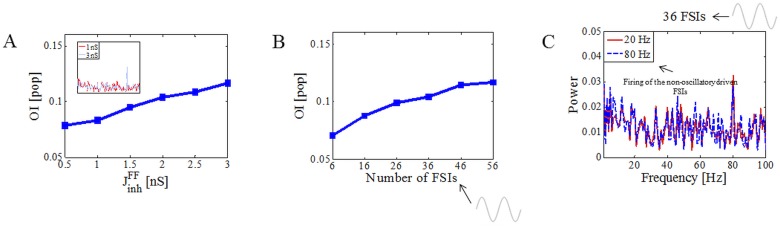
Sensitivity of the oscillations in the MSN population to the parameters of the FF inhibition.(A) Increase in the strength of FF inhibition enhanced the transfer of oscillations from FSIs to MSNs as indicated by a monotonic increase in the OI of MSNs. (B) OI of MSNs also monotonically increased as a fraction of stimulated FSIs increased. (C) Influence of the background activity in unstimulated FSIs (those that did not receive any sinusoidal inputs) on the transfer of oscillations to the MSN population. Maximal amplitude of the oscillatory inputs was equal to 350 pA (mean ± std firing of FSIs was equal to 30.98 ± 4.2 Hz) and was kept constant throughout all simulations.